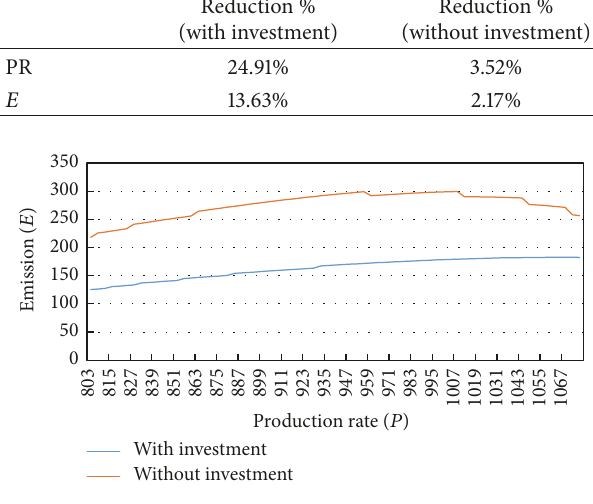
Figure 4: 𝑃 versus emission (𝐸)